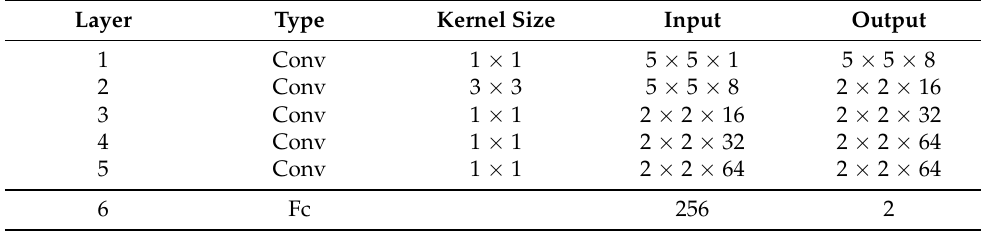
Table 2. The structure and parameters of a deep convolutional neural network.